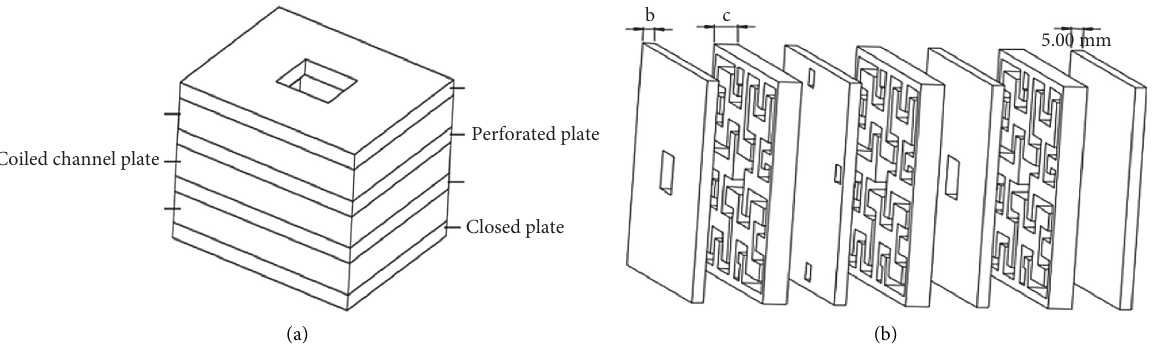
Figure 1: Coiled acoustic metamaterial structure diagram. (a) Coiled acoustic metamaterial structure. (b) Internal structure of metamaterials.